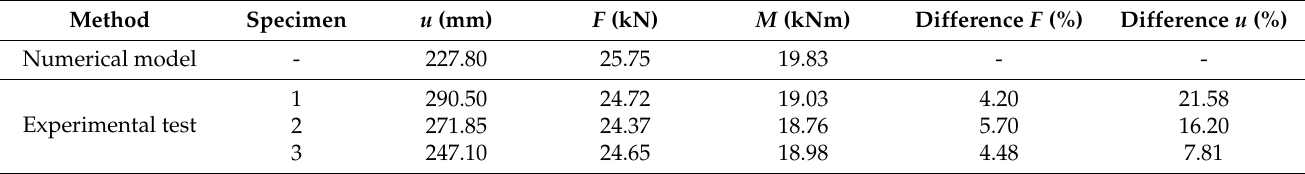
Table 11. Results of Experiment B (fully threaded